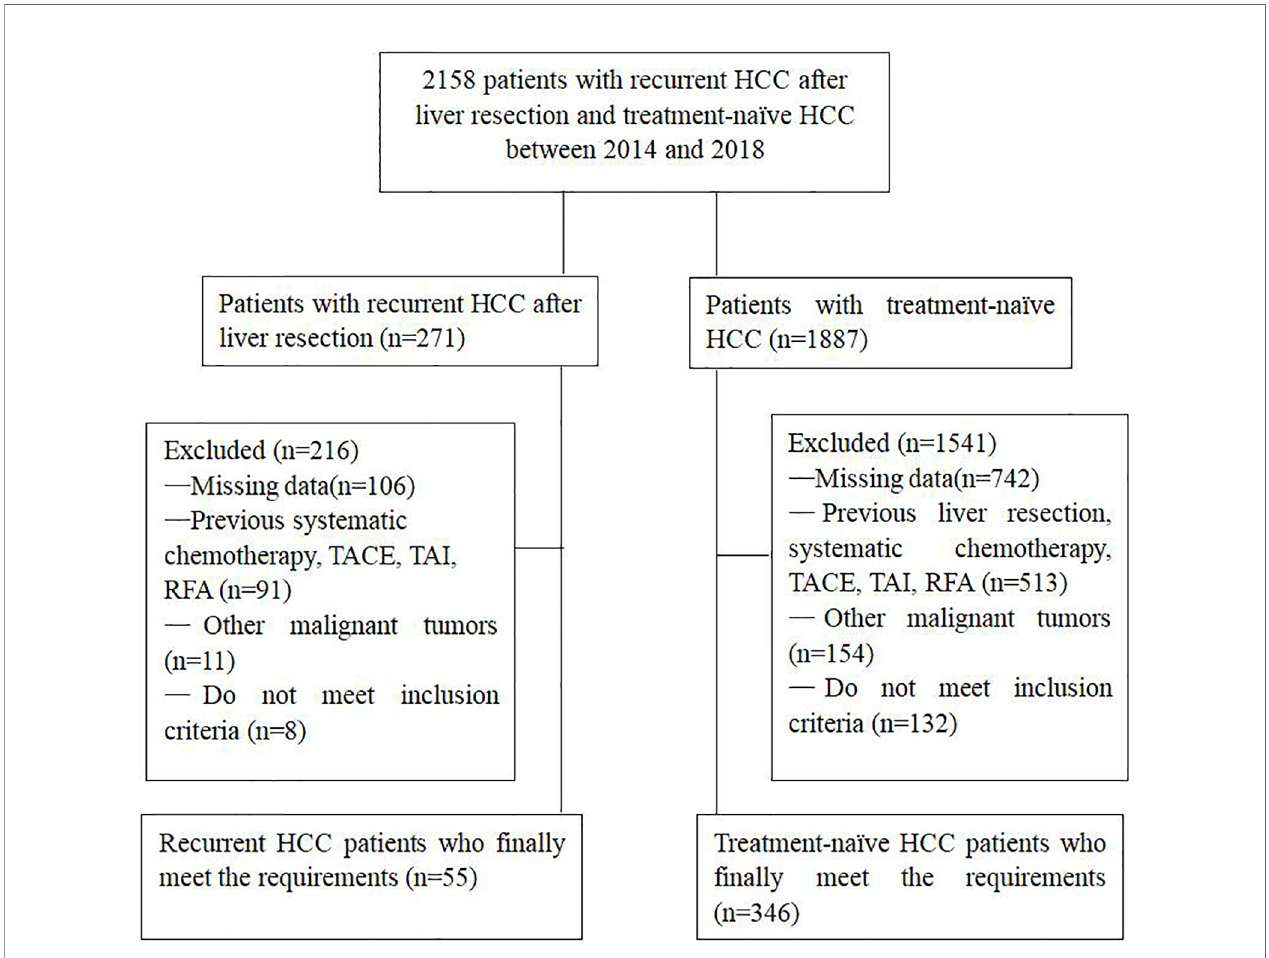
FIGURE 1 | Flow chart shows the screening procedure for patients with recurrent HCC after liver resection and treatment-naïve